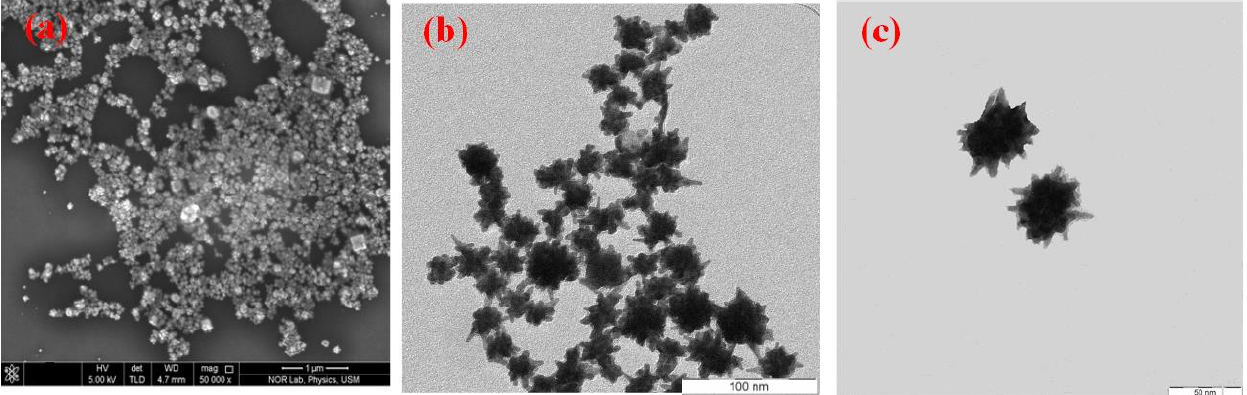
Figure 2. Spiky durian-shaped Au@Ag NPs ( a ) FESEM image with 1 µm scale, ( b ) TEM image with 100 nm scale, and ( c ) higher resolution TEM image with 50 nm scale.